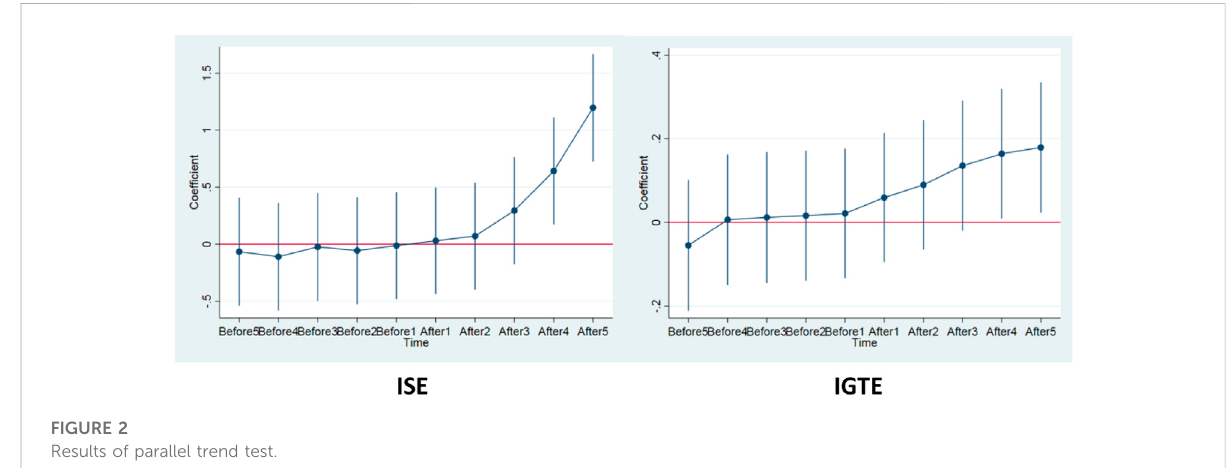
FIGURE 2 Results of parallel trend